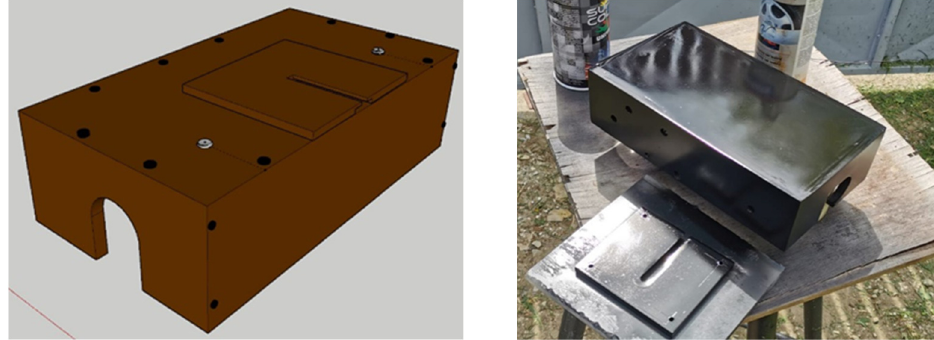
Figure 4. The trolley design in SketchUp Pro and the final prototype. Three wheels were manufactured for the sliding and traction system of the trolley.